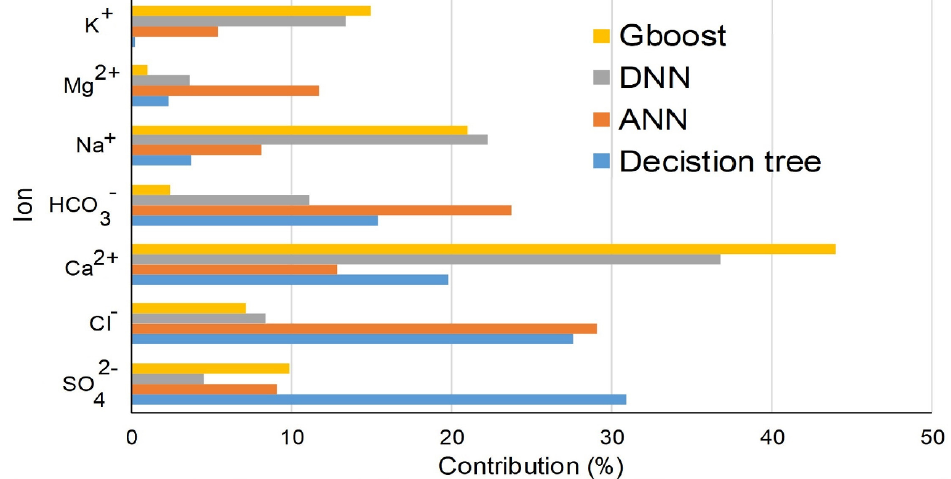
Figure 9. The percentage importance of different major ions in the Middle East precipitation (obtained from various machine learning models).